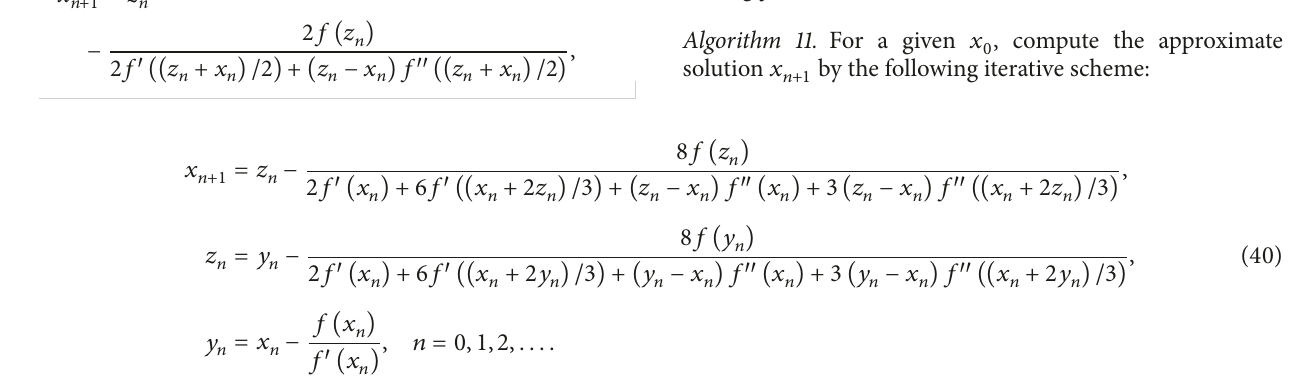
Algorithm 2 reduces to the following iterative method for solving 𝑓(𝑥) = 0 . Algorithm 11. For a given 𝑥 0 , compute the